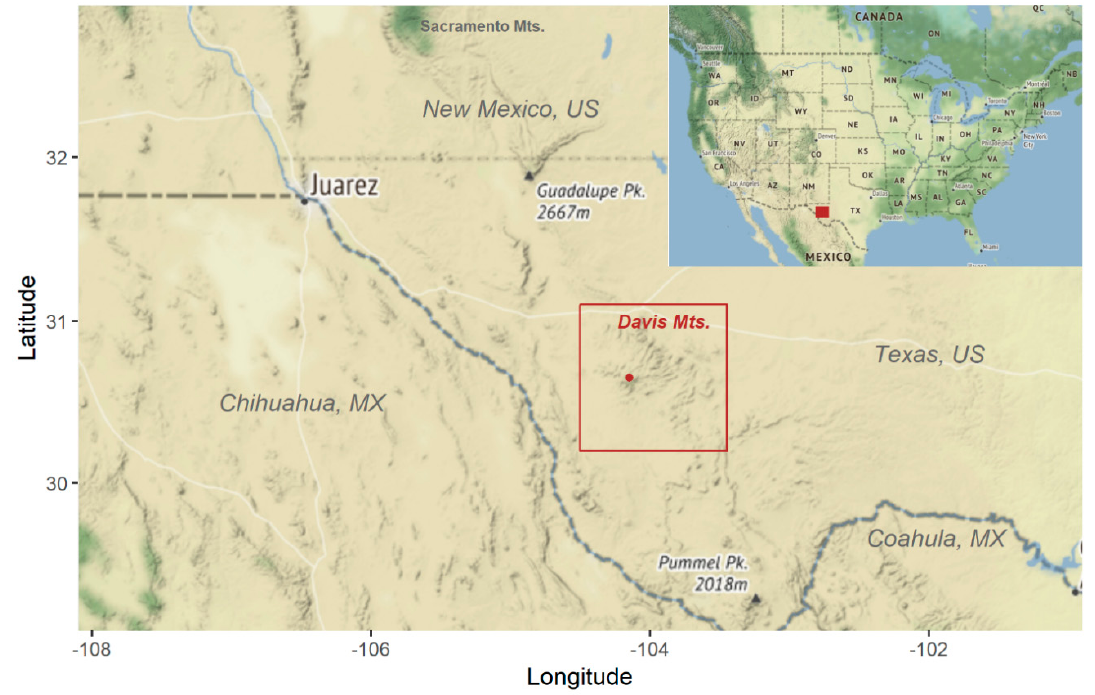
Figure 1. Study location (point) within the Davis Mountains (box) of western Texas, USA.